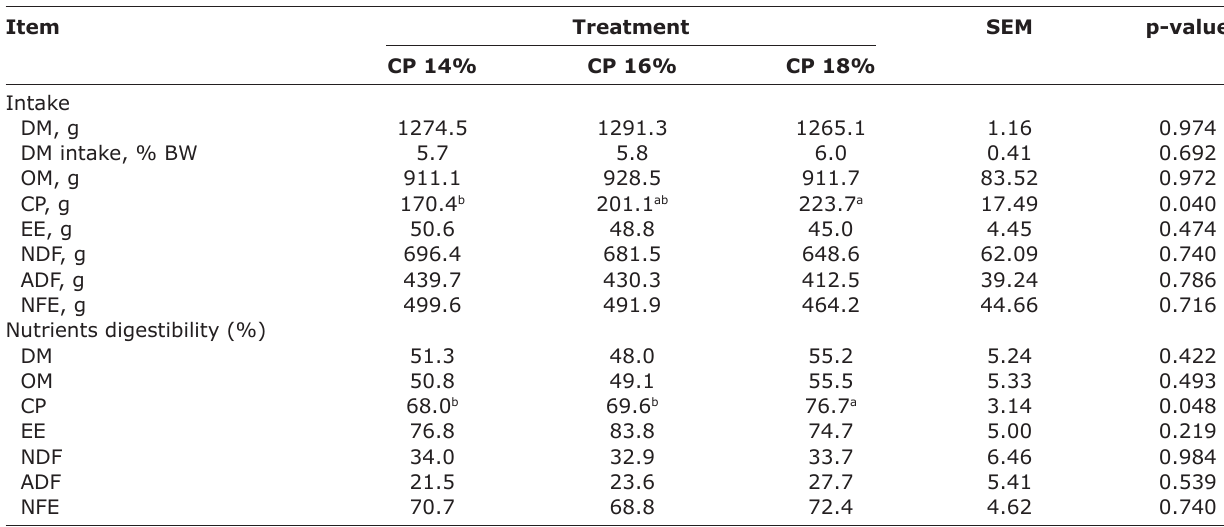
Table-7: Nutrient intake and apparent digestibility. Item Treatment SEM